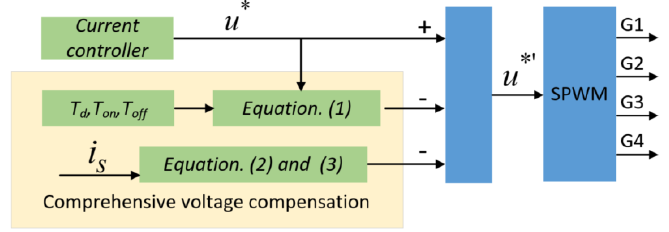
Figure 10. The comprehensive voltage compensation block diagram of one phase of a TL-NPC inverter.